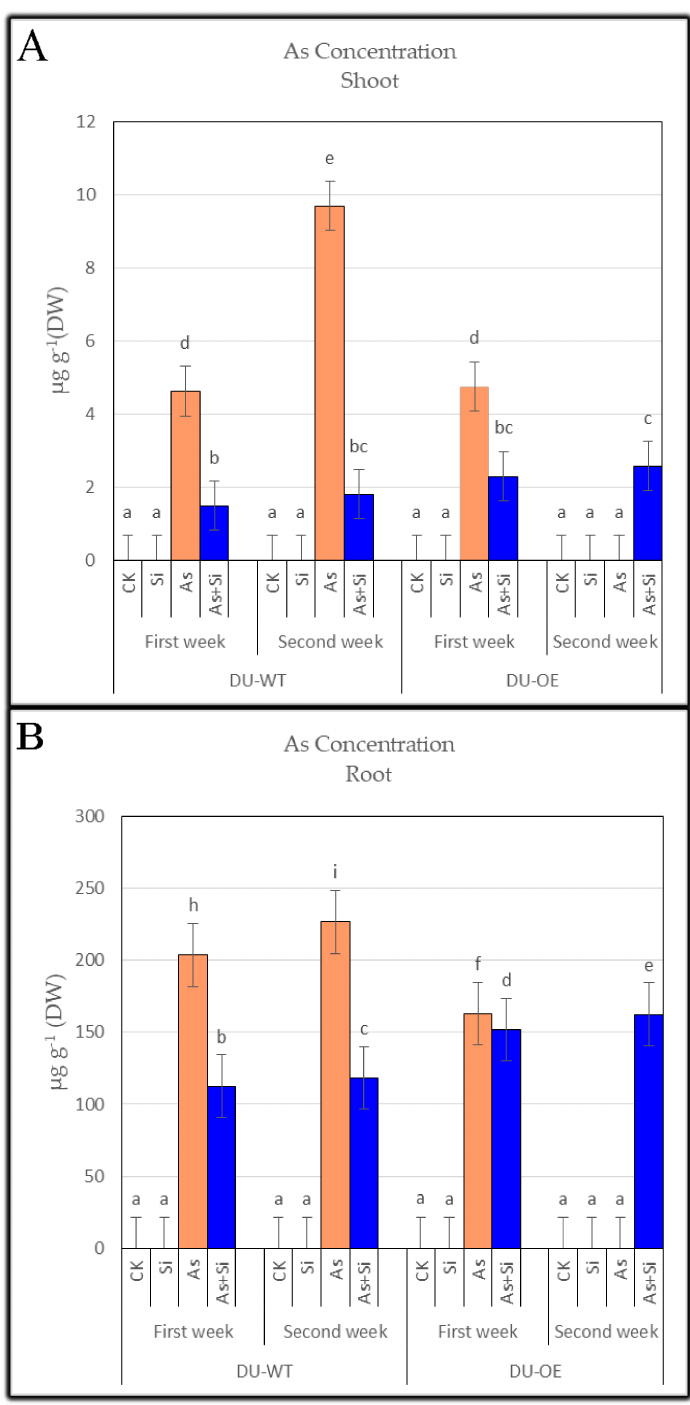
Figure 1. The arsenic concentration of DU-WT and DU-OE shoots, the first and second weeks after adding treatments ( A ). The arsenic concentration of DU-WT and DU-OE roots, the first and second weeks after adding treatments ( B ). The different letters on the bars indicate a significant difference among independent treatments ( p ≤ 0.05); (DW: dry weight; CK: control; Si: 0.70 mM Si; As: 30 µ M As; As+Si: 30 µ M As + 0.70 mM